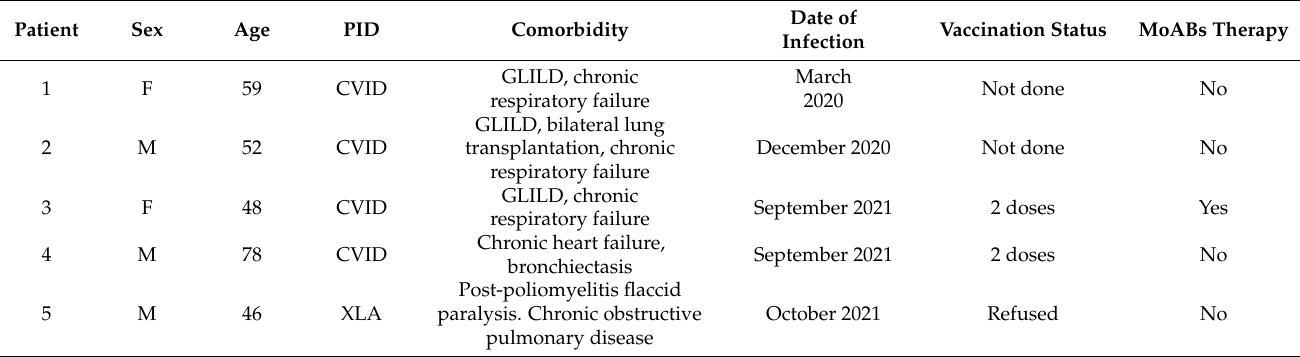
Table 3. Data of patients who died during the two years of SARS-CoV-2 pandemic.